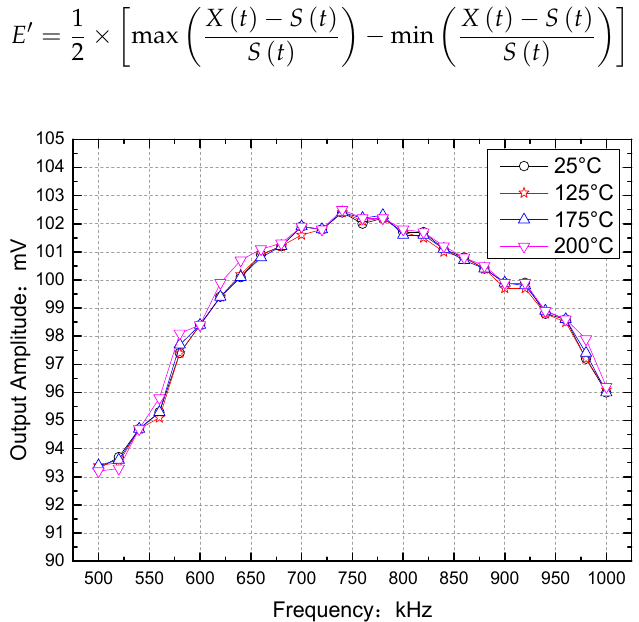
Parameter Table 6. Q values for the digital lock-in amplifier at different temperatures.